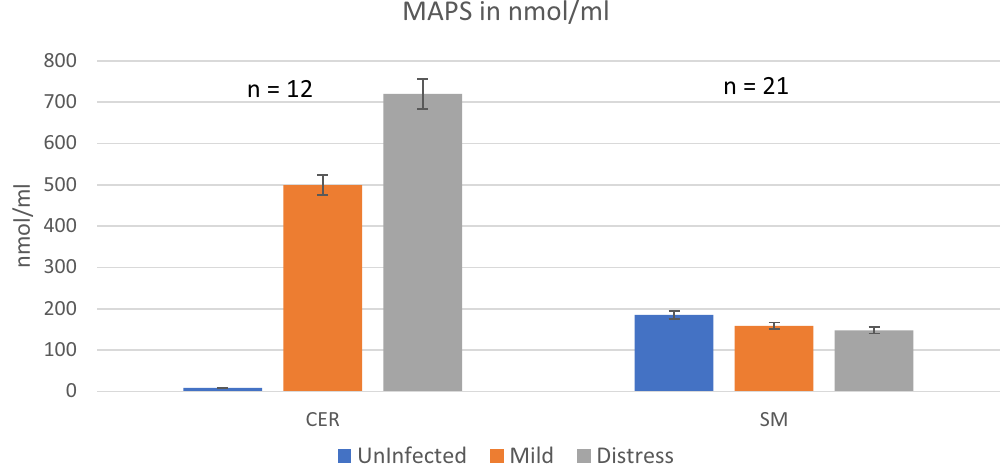
Figure 5. Total Levels of Ceramide class of lipids in Plasma of the Covid-19 infected. Fold sum of MEDM changes of peak area times number of subclasses identified per lipid class. ( a ) An overall estimation of relative changes in the concentrations of various lipid classes. ( b ) Relative concentration of lipids per class in μmoles/l of plasma as determined via the SRM 1950 consensus LIPID MAPS consortium. Error bars represent, standard deviation of